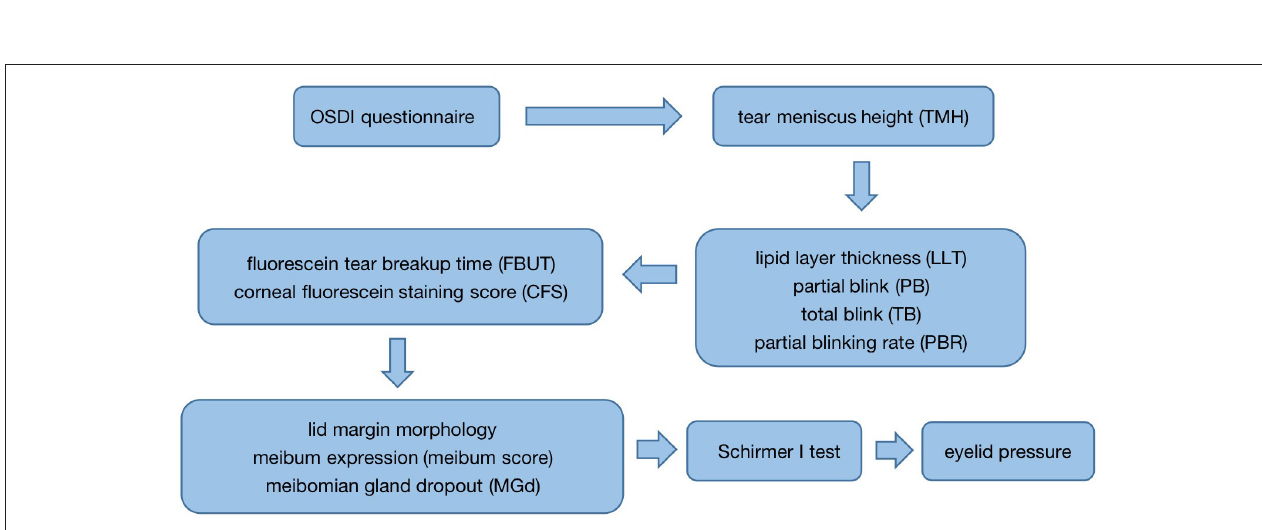
FIGURE 2 | Working interface of the pressure measurement device. The measured pressure was divided into two phases: an increasing phase and a plateau phase.